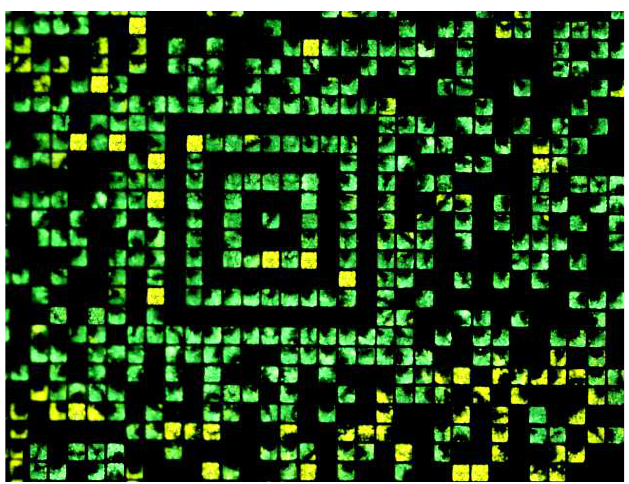
Figure 7. Ordering of polymorphs. Fluorescence image of compound 1 patterned on silicon surface as an Aztec code. Each printed structure is 20 × 20 µm2 and contains only a polymorph (green or yellow) in >98% of pixels.